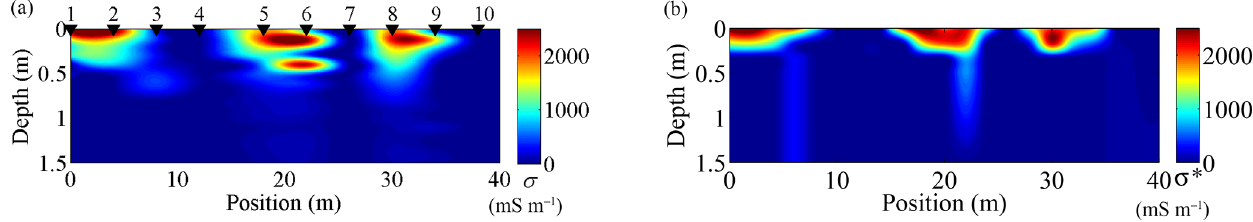
Figure 5. (a) Electrical conductivity (mSm − 1 ) measured by the 5TE capacitance sensors from 10 soil pits along transect and the location of the soil pits is indicated by black triangles (Jadoon et al., 2015); (b) the soil electrical conductivity obtained by using Markov chain Monte Carlo simulation for multi-configuration electromagnetic induction measurements.